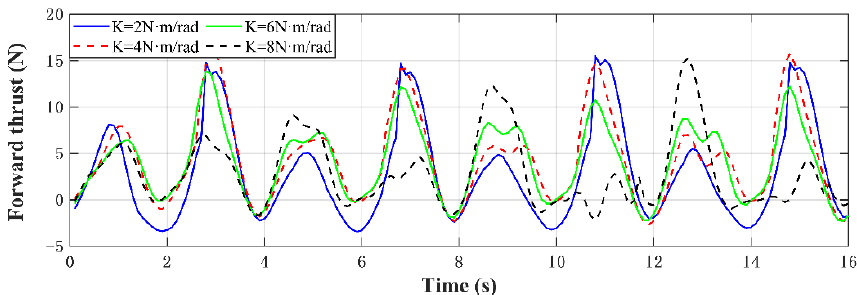
Figure 12. The forward thrusts of the conventional submerged glider under the different K. The pressure nephogram of the hydrofoil in a period is shown in Figure 13. The hydrofoil with torsion spring stiffness K = 2 N · m/rad generated less torque at t/T = 1, which caused a small restoring moment of the hydrofoil. Thus, the hydrofoil cannot be returned to the horizontal state at this time.